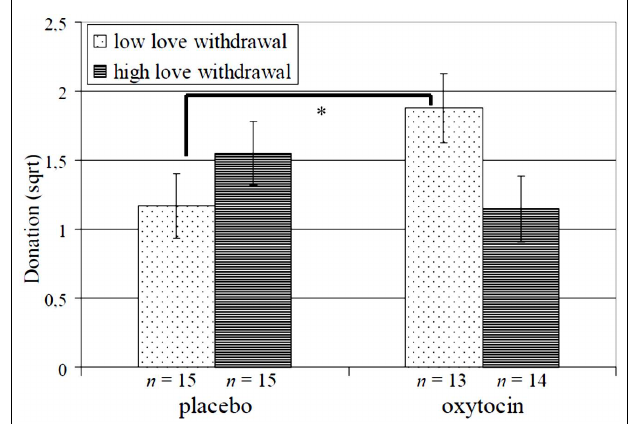
FIGURE 1 |Amount of money (square root) donated to UNICEF ( M , SE) by participants reporting high versus low love-withdrawal in the oxytocin and placebo